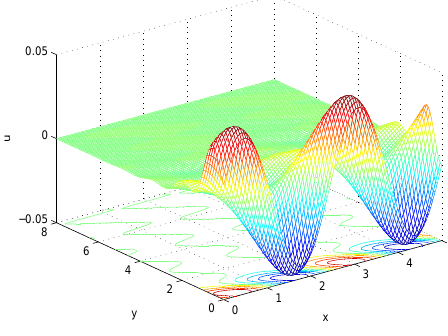
Fig. 7 Distribution the displacement component u against both components of distance in the TPL model with diffusion.